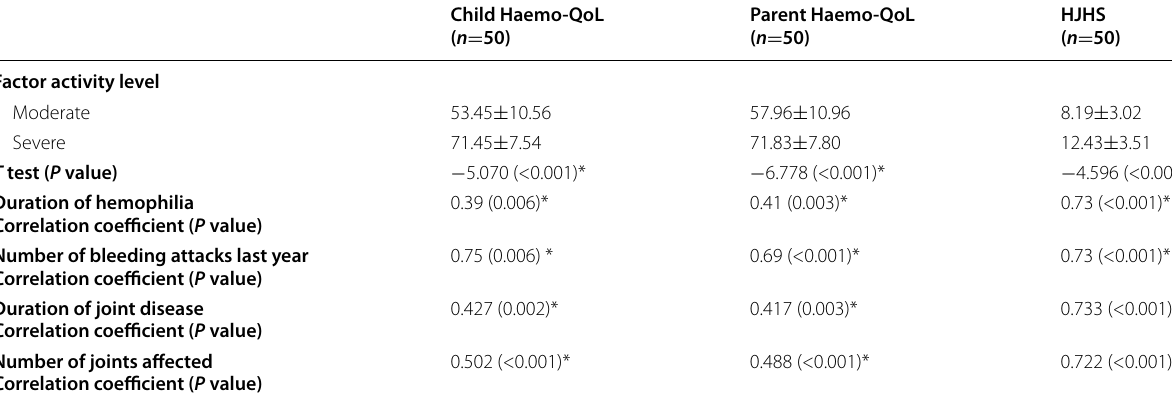
Haemo-QoL Haemo quality of life, HJHS hemophilia joint health score * Statistically significant at P 0.05 ≤ Table 6 Comparison between age groups with Haemo-QoL score of child and parent and HJHS